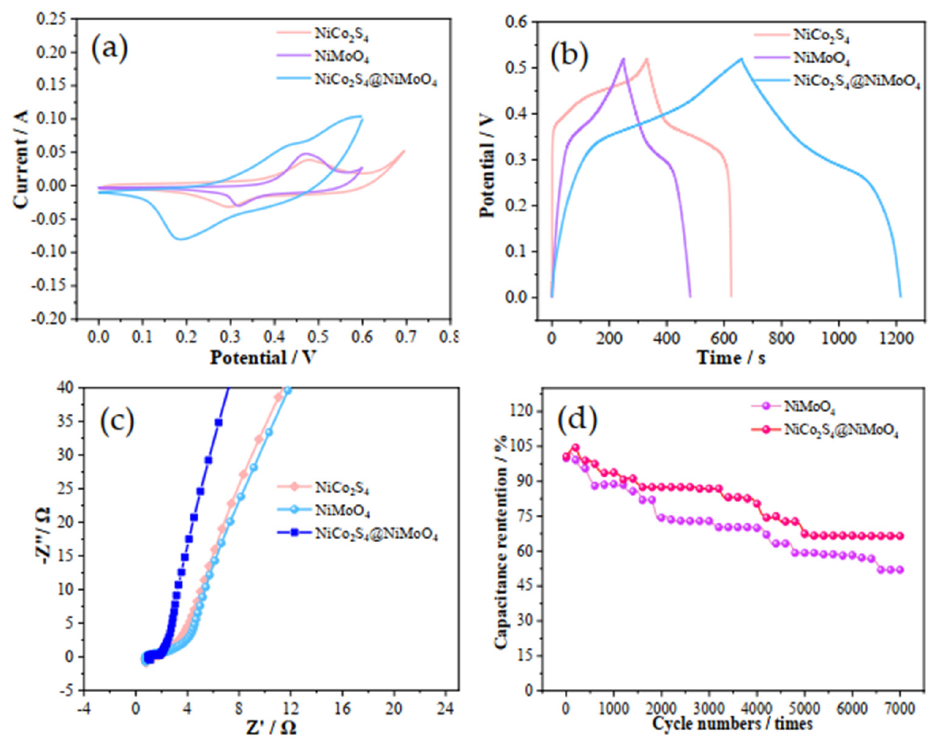
Figure 5. ( a ) Comparison of CV curves of NiCo 2 S 4 @NiMoO 4 samples, ( b ) Comparison of GCD curves, ( c ) electrochemical impedance spectroscopy, ( d ) cycle stability.